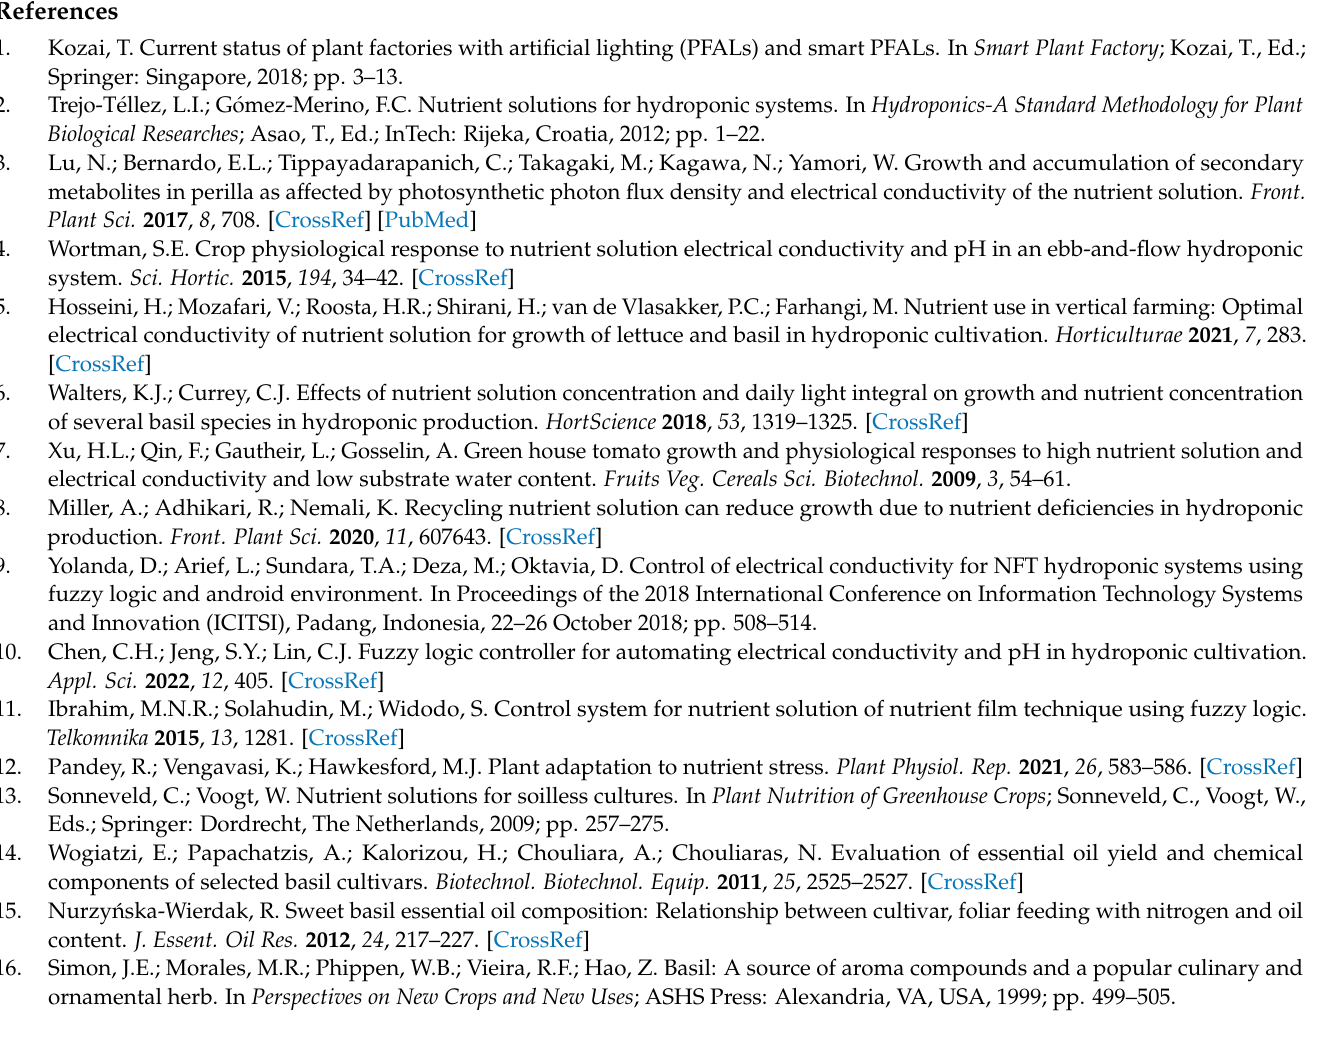
ments, Figure S2: Basil plants grown under 4 different EC treatments for 18 days after transplanting, Figure S3: The plant dry weight of basil under 4 different EC treatments for 18 days after transplanting and the scatter plots for the relationship between the plant dry weight of basil and the leaf area, Table S1: Growth parameters of basil plants grown under 4 different EC treatments in experiment 1, Table S2: The stomatal conductance (Gs), transpiration rate (Tr), and water use efficiency of photosynthesis (WUE Pn ) of basil leaves under 4 different EC treatments for 18 days after transplanting in experiment 1, Table S3: Growth parameters of basil plants grown under different EC treatments in experiment 2, Table S4: The percentage decrease in leaf fresh weight of basil compared with the control and the percentage increase in antioxidant capacity, total phenol contents (TPC), antioxidant capacity in leaves of the whole plant, TPC in leaves of the whole plant of basil compared with the control in experiment